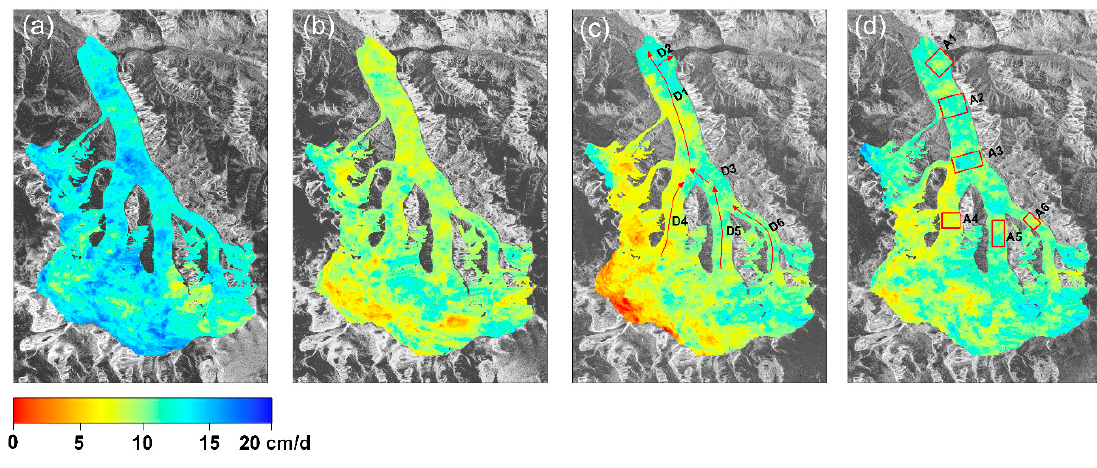
Figure 5. Time series of glacier flow velocities during four periods: ( a ) 1 July 2018 − 13 July 2018; ( b ) 13 July 2018 − 25 July 2018; ( c ) 25 July 2018 − 6 August 2018; ( d ) 6 August 2018 − 18 August 2018. The background image is from Sentinel-1A intensity data. The red curves (D1 − D6) in ( c ) mark the profiles shown in Figure 6, and the red rectangles (A1 − A6) in ( d ) mark the areas shown in Table 2.